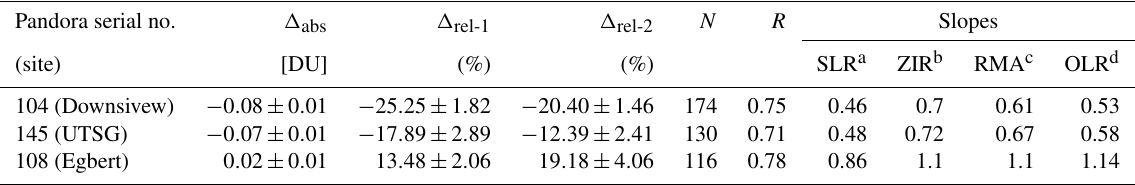
Table A1. TROPOMI KNMI vs. Pandora total column NO 2 , using the standard approach. Pandora serial no.